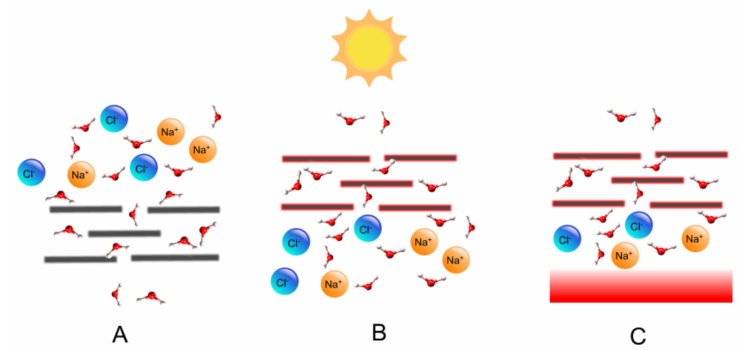
Figure 7. Schematics of: ( A ) typical filtration desalination; ( B ) solar-driven desalination; and ( C ) heat- driven